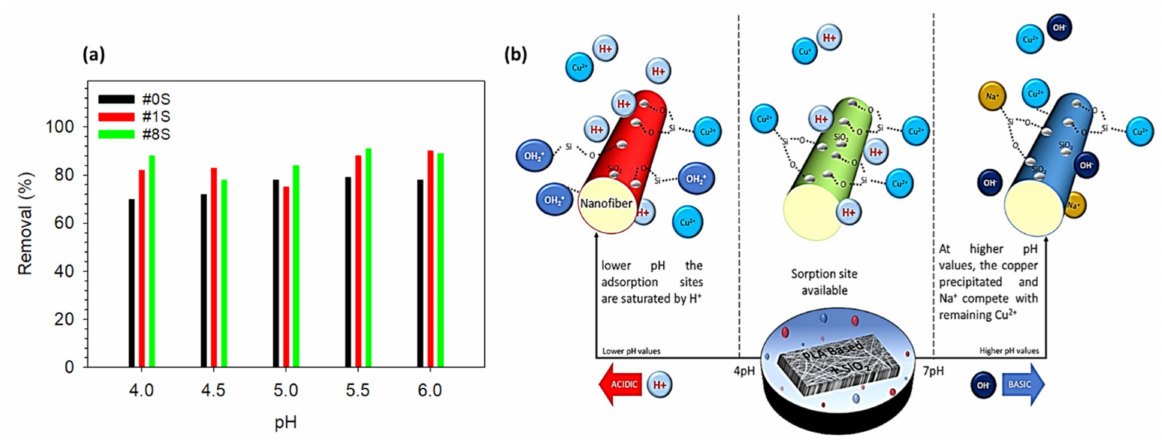
Figure 5. ( a ) The impact of pH on the adsorption of Cu 2+ onto PLA-based nanofibrous adsorbents. ( b ) Schematic illustration of the adsorption of a heavy metal (in this case, copper) onto a prepared nanofibrous adsorbents. At lower pH values, H + saturates the adsorption sites and copper ion adsorption is low. The availability of sorption sites and the adsorption of copper ions both increase